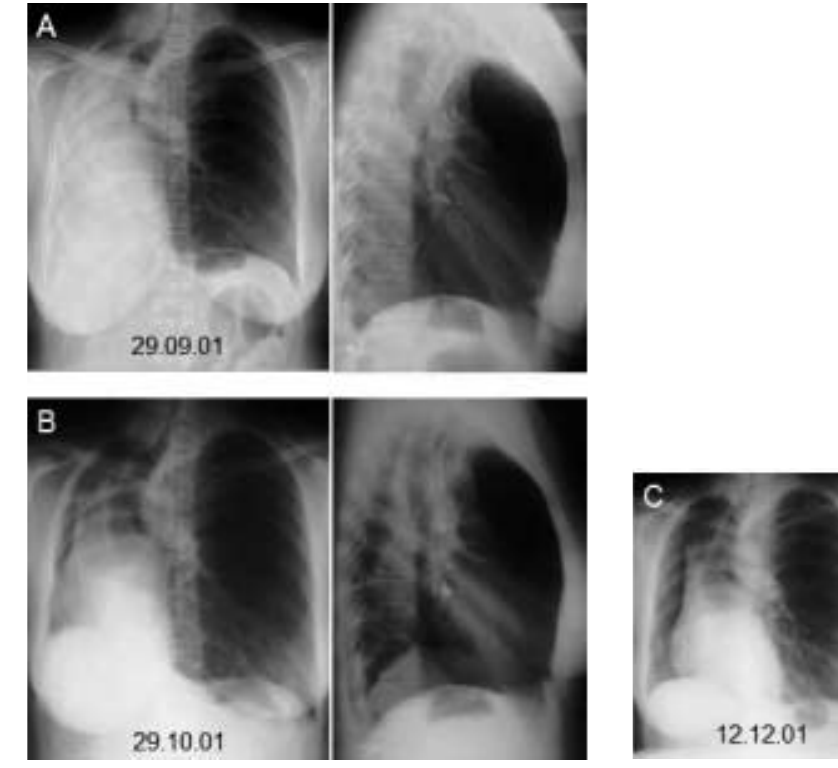
Lymphomatous tracheobronchitis: A: The tracheal wall shows diffuse thick- ening due to lym- phomatous inflam- mation. The cartilage is not affected and the geometry of the trachea remains intact. B: After administra- tion of infliximab (5 mg/kg bodyweight) the tracheal wall appears